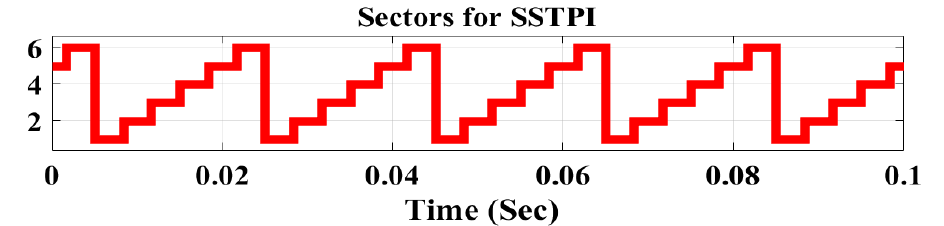
Figure 11. Sectors of pulse width modulated voltage of